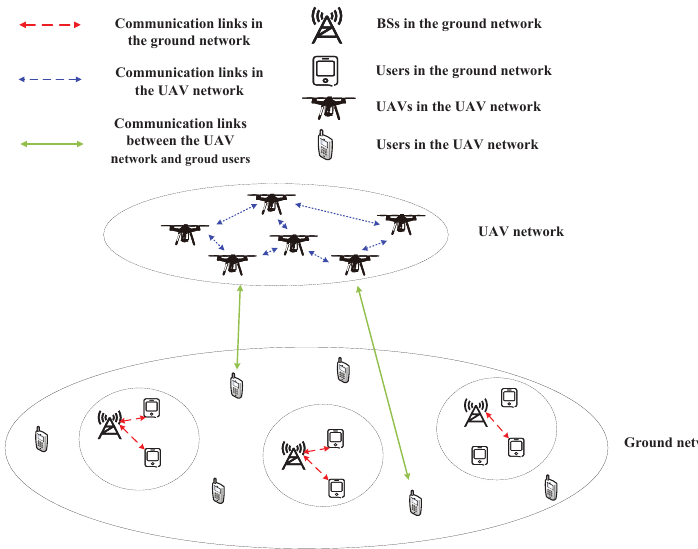
Figure 2. Spectrum sharing between LAP networks and ground